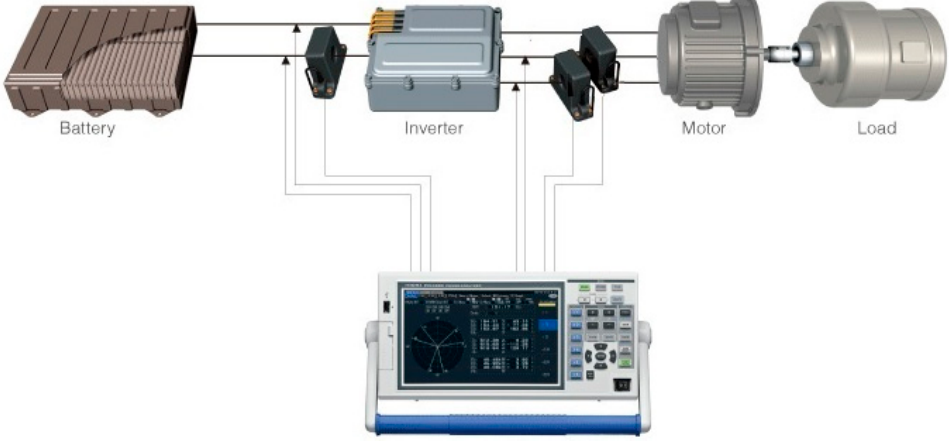
Figure 2. Testing equipment configuration.